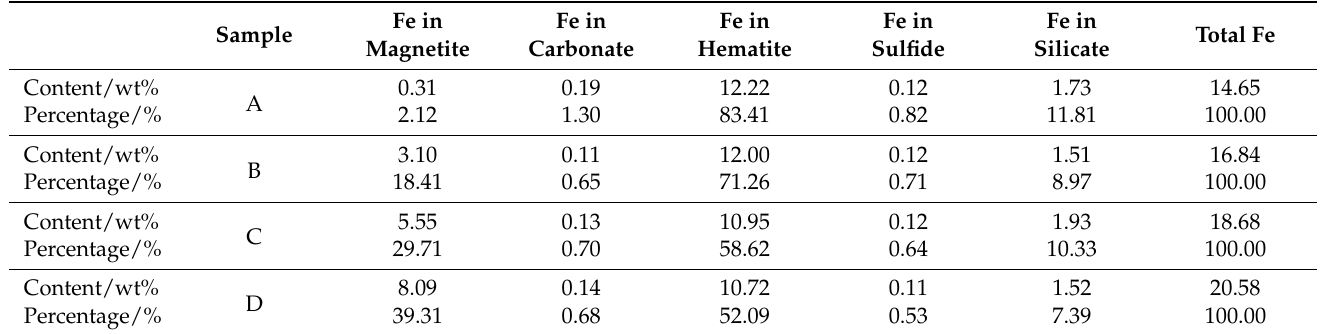
Table 4. The iron phase composition and Fe content of sample A, B, C and